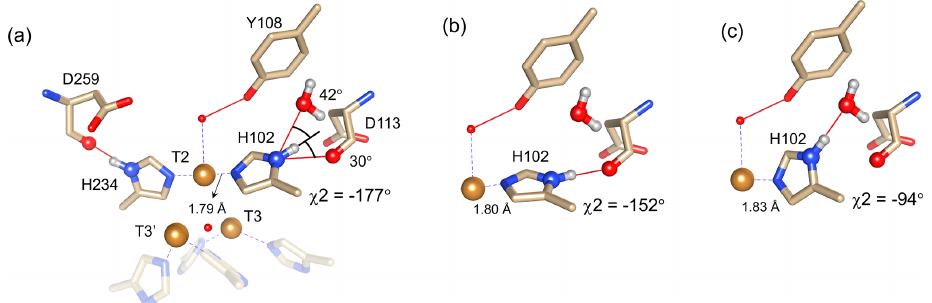
Figure 4. Alternative hydrogen bond acceptors for His102. (a) T2 site histidine ligands showing the hydrogen bonds for the N δ 1–H δ 1 groups. Protons were modelled using the algorithm as implemented in UCSF Chimera (Pettersen et al., 2004). His104 and H236 from the T3 (cid:48) and T3 sites, respectively, are omitted for clarity. Hydrogen bonds are shown as red lines. The χ 2 dihedral angle and distance between His102 N ε 2 and the T2 copper are indicated. Also, the values for the angles [Asp113 CO − His102 N δ 1 − His102 H δ 1] and [water O628 − His102 N δ 1 − His102 H δ 1] are indicated. Ring rotation brings the H δ 1 in optimal position for hydrogen bond formation with either the Asp113 CO (b) or the water (c) . The new χ 2 dihedral angles and the corresponding His102 N ε 2–T2 copper distances are